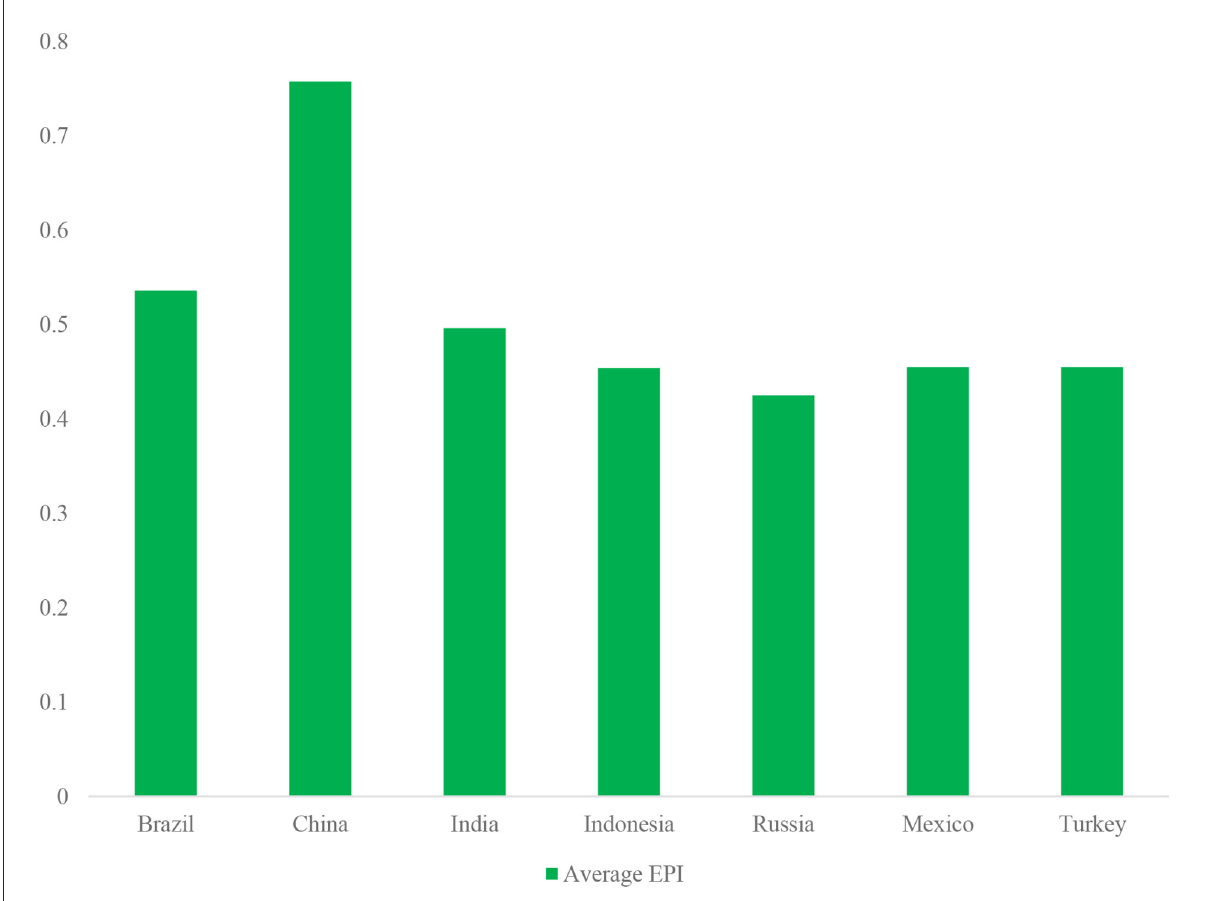
FIGURE3 The average EPI of E7